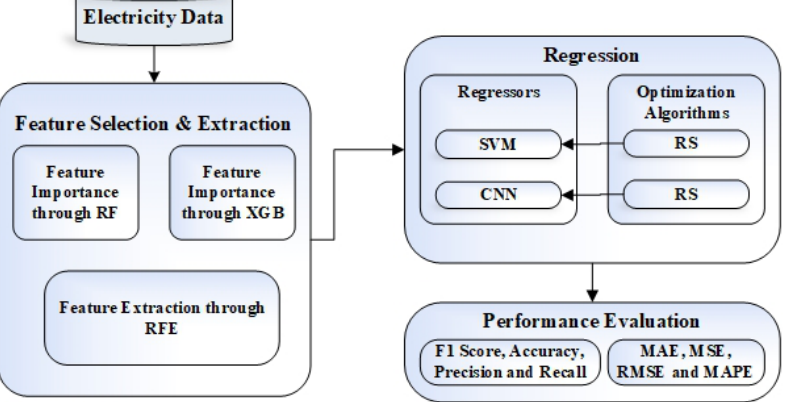
Figure 2. Proposed system model for electric load